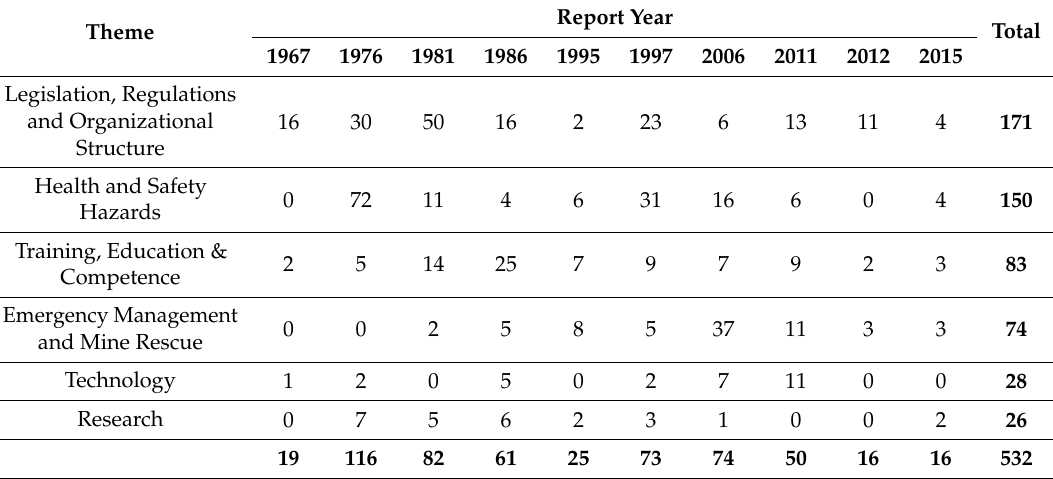
Table 2. Number of recommendations coded per theme by report